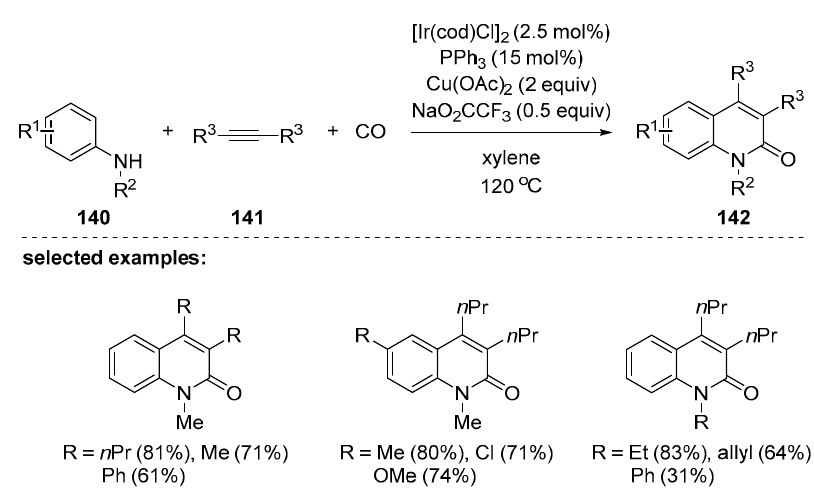
Scheme 41. Synthesis of 2-quinolinone by Ir-catalyzed three-component reactions.